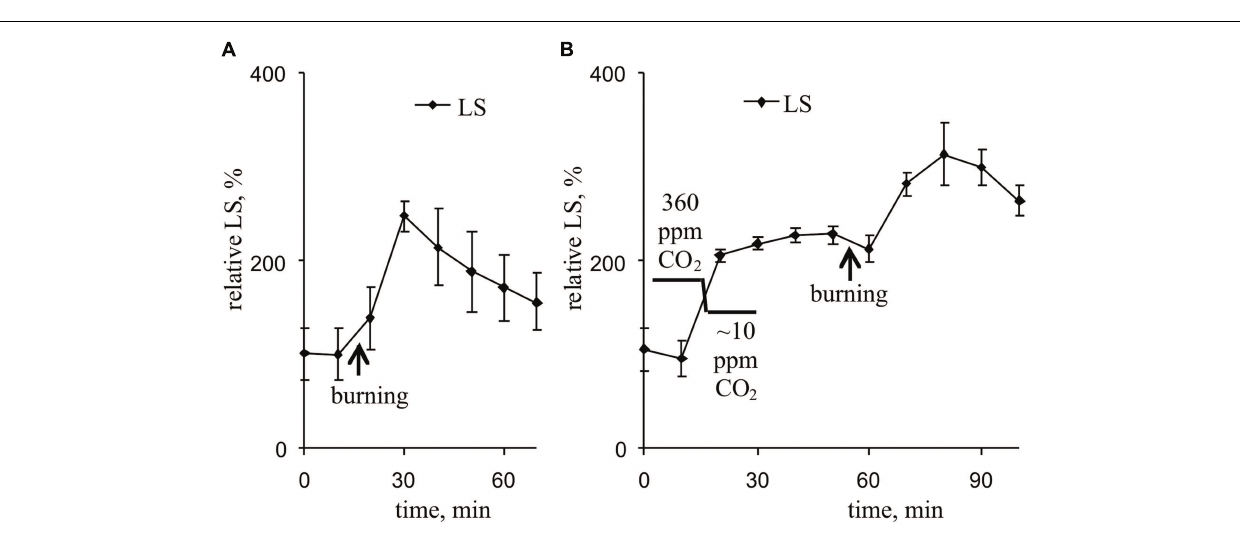
FIGURE 7 | Changes in the relative LS induced by VP at 360 ppm (A) and approximately 10 ppm (B) CO 2 ( n = 6–8). The mean LS magnitudes prior to VP or a decrease in the CO 2 were assumed to be 100%. Points were measured every 600 s (450 s light, 150 s dark). The VP was induced by burning the first mature leaf